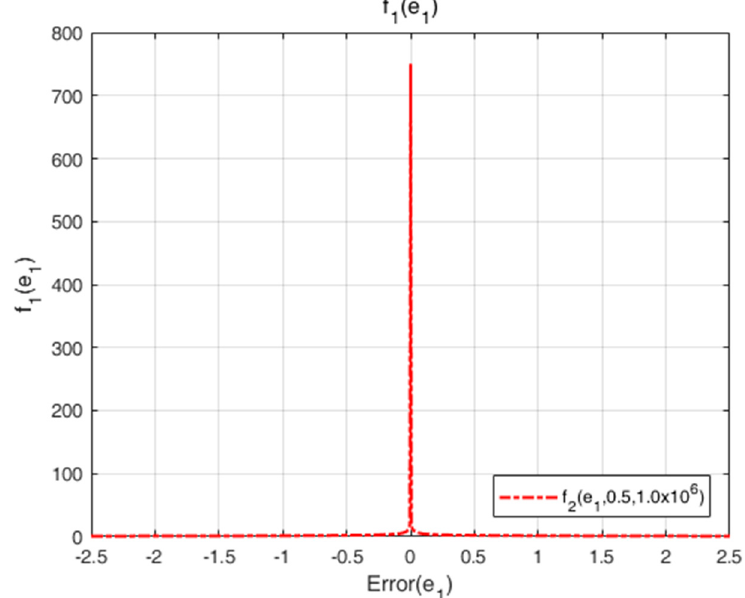
Figure 10. Curve of f ( e 1 ) Figure 10. curve of 1